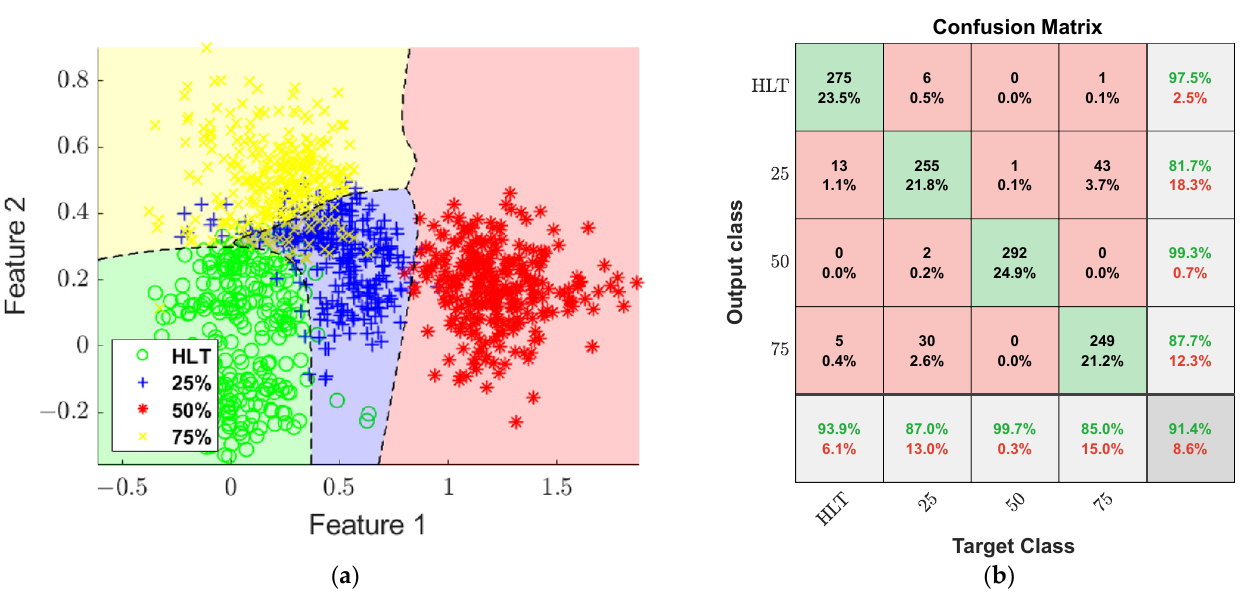
Figure 11. Feature optimization through the proposed methodology with Gaussian noise added for 40 dB, in ( a ) Two-dimensional projection of clusters (fault conditions) through LDA with limit bounds, and ( b ) Confusion matrix that validates the ANN classification of faults.